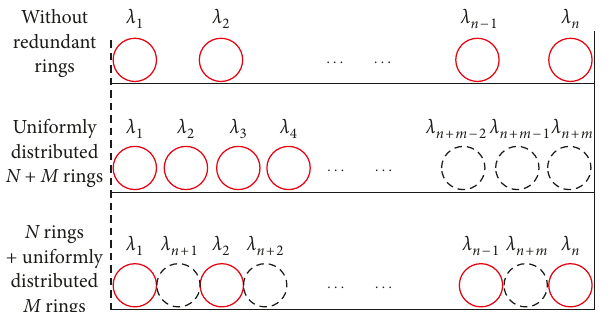
Figure 5: Two distribution schemes of redundant rings.